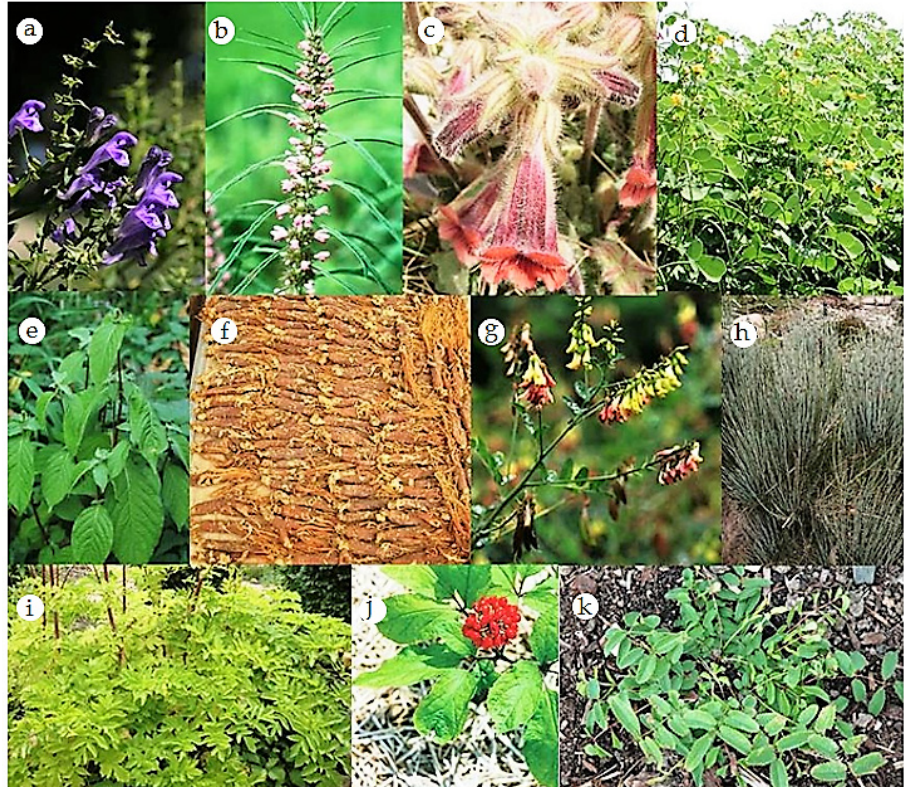
Figure 3. Examples of herbs used in Chinese herbal medicine: ( a ) Scutellaria ; ( b ) Leonurus artemisia ; ( c ) Rehmannia ; ( d ) Cassia obtusifolia ; ( e ) Achyranthis bidentata ; ( f ) Panax ginseng root; ( g ) Astragalus membranaceus ; ( h ) Ephedra intermedia ; ( i ) Angelica sinensis ; ( j ) Panax ginseng plant; ( k ) Sanguisorba officinalis . Reprinted with permission from ref. [23]. Copyright 2019 Jade Institute (Seattle, WA, USA).